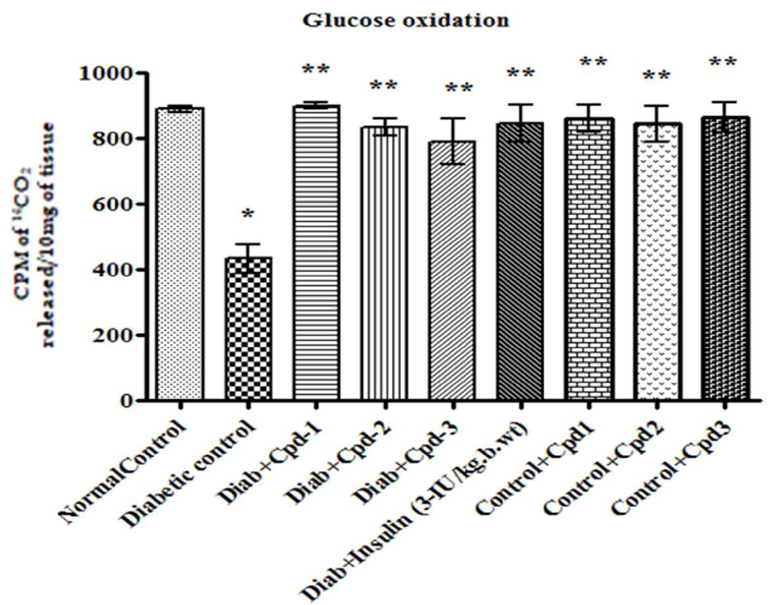
Figure 6. Effect of novel triterpenoids on glucose oxidation in STZ-induced diabetic rats compared with the effect of insulin. Each bar represents mean ± SEM of 6 animals. Significance at p < 0.05; *, compared with control; **, compared with diabetic control.